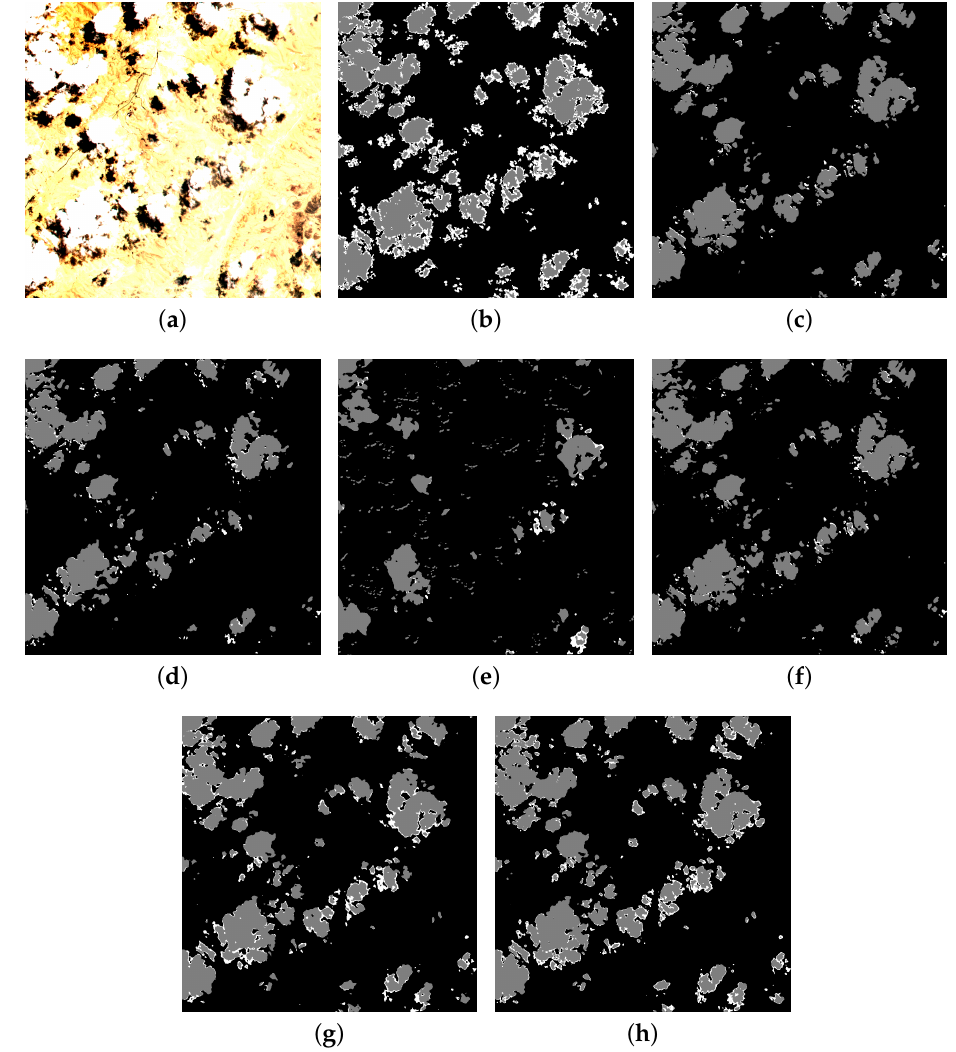
Figure 14. Multi-class detection of clouds on a patch of an S05 Ven µ s tile with various inputs using U- Net—Dropout 0%. White represents thin clouds, grey represents thick clouds. ( a ) RGB representation of a patch of an S05 VEN µ S tile; ( b ) ground-truth mask; ( c ) after a training using full-band input; ( d ) using only RGB; ( e ) using RGB enhanced with NDVI; ( f ) using augmented full-band input; ( g ) using only augmented RGB; ( h ) using augmented RGB enhanced with